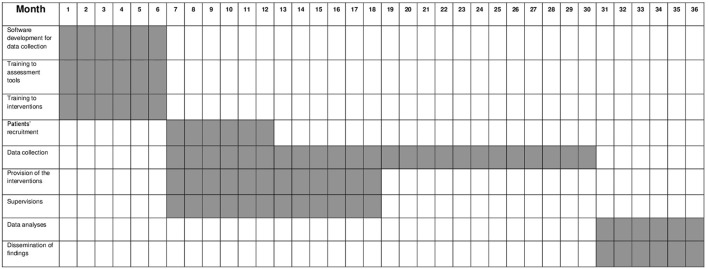
Stepwise procedure.